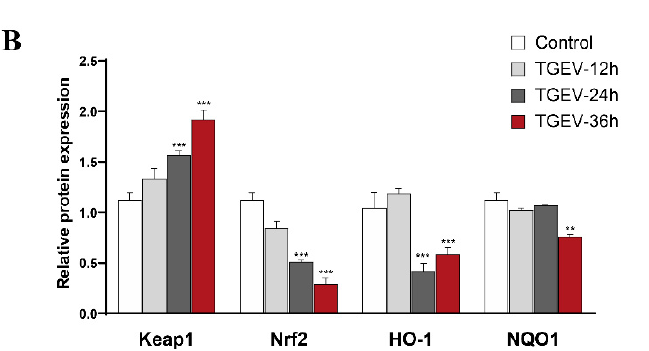
Figure 6. TGEV damages the antioxidant capacity of IPEC-J2 cells. ( A , B ) Protein abundance of Keap1, Nrf2, HO-1 and NQO1 in IPEC-J2 cells ( n = 3). Data are expressed as the mean ± SEM. ** p < 0.01, *** p < 0.001.